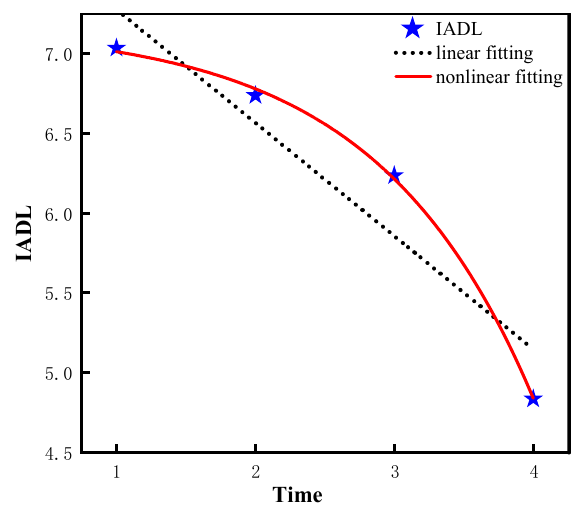
Figure 4. Trajectory of ADL ability of older adults.